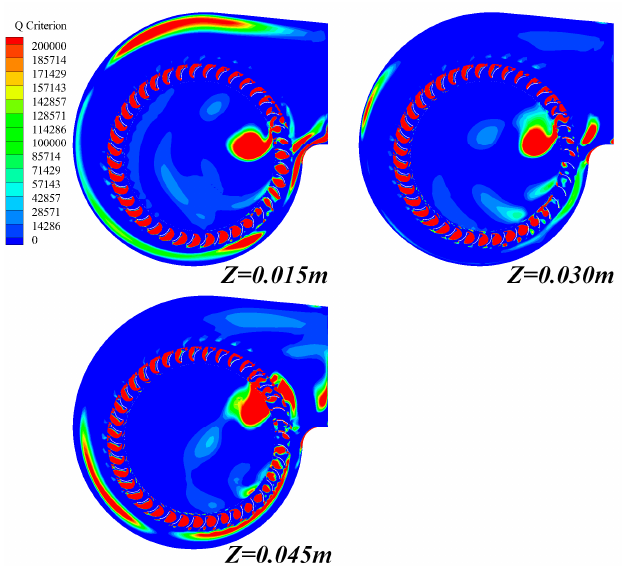
Figure 16. Q value distribution of cross-sections at different positions (Q/Qn = 1.758).